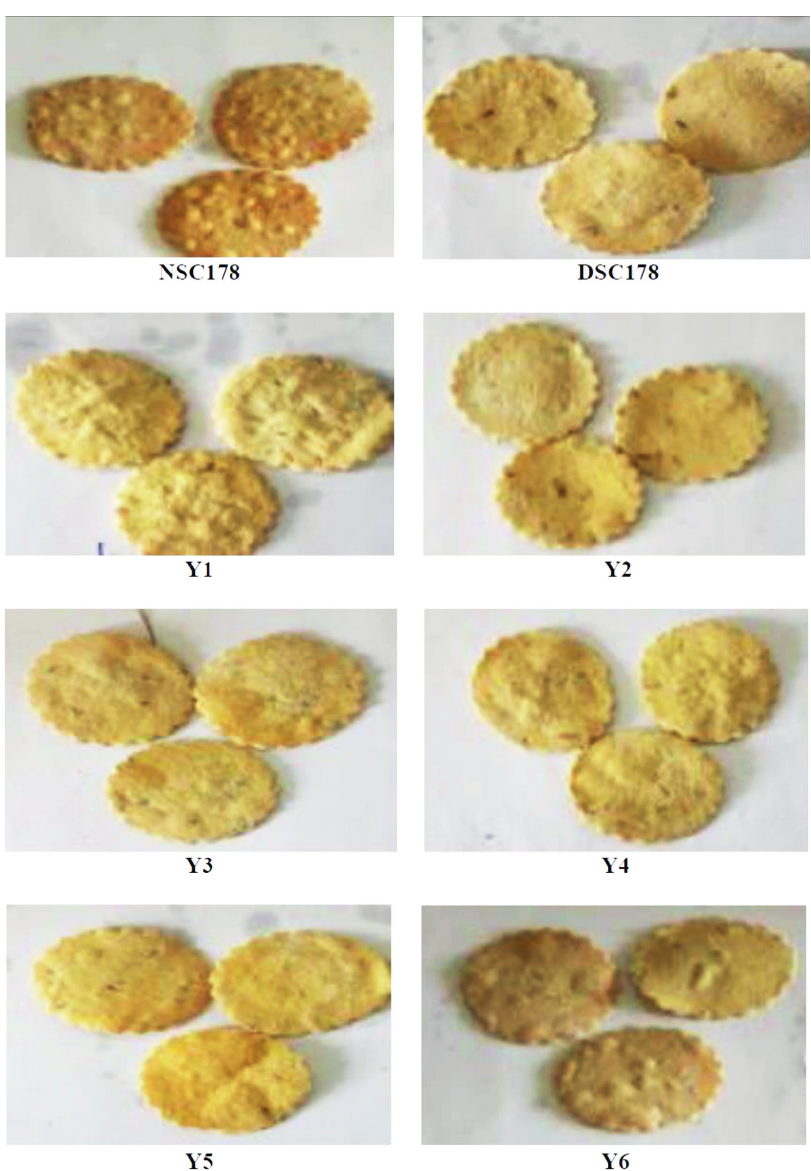
Figure 2 Snacks processed from drought-tolerant corn genotypes. NSC178 = Single Cross Giza 178 planted under normal conditions, DSC178 = Single Cross Giza 178 planted under drought conditions, Y1–Y6 = new yellow corn hybrids planted under drought